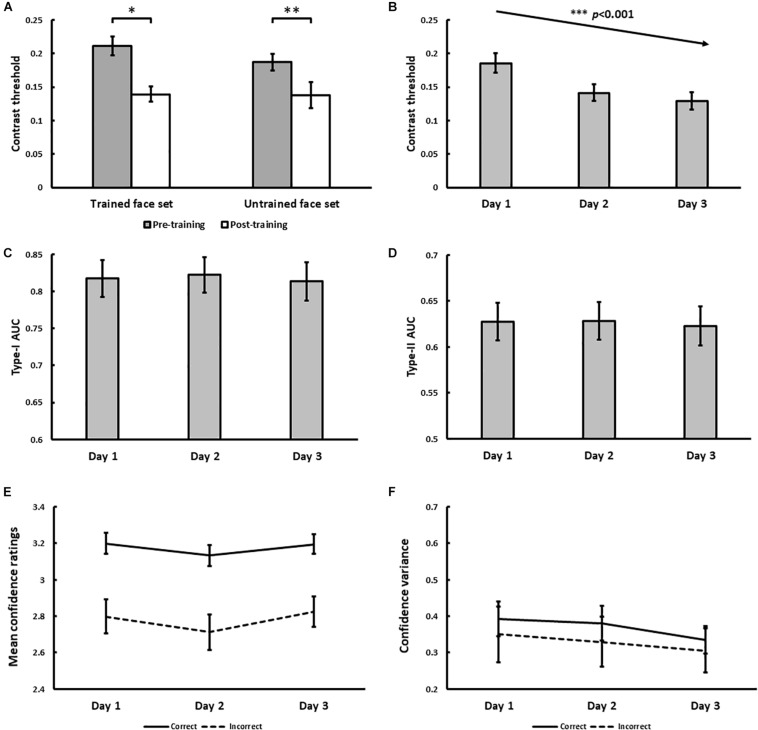
Results for Experiment 2. (A) Pre- and post-training effects measured as median contrast threshold for trained and untrained face sets before (on Day 1) and after (on Day 3) training sessions. (* and ∗∗ indicate p < 0.05 and p < 0.01, respectively). Although threshold significantly decreased with training over 3 days (B), none of the following changed with training: Type-I AUC for objective accuracy (C), Type-II AUC for metacognitive accuracy (D), confidence ratings for correct (solid) and incorrect (dashed) trials (E), and the variance of confidence ratings for correct (solid) and incorrect (dashed) trials (F). Error bars denote ± 1 within-subjects SEM (Cousineau, 2005).